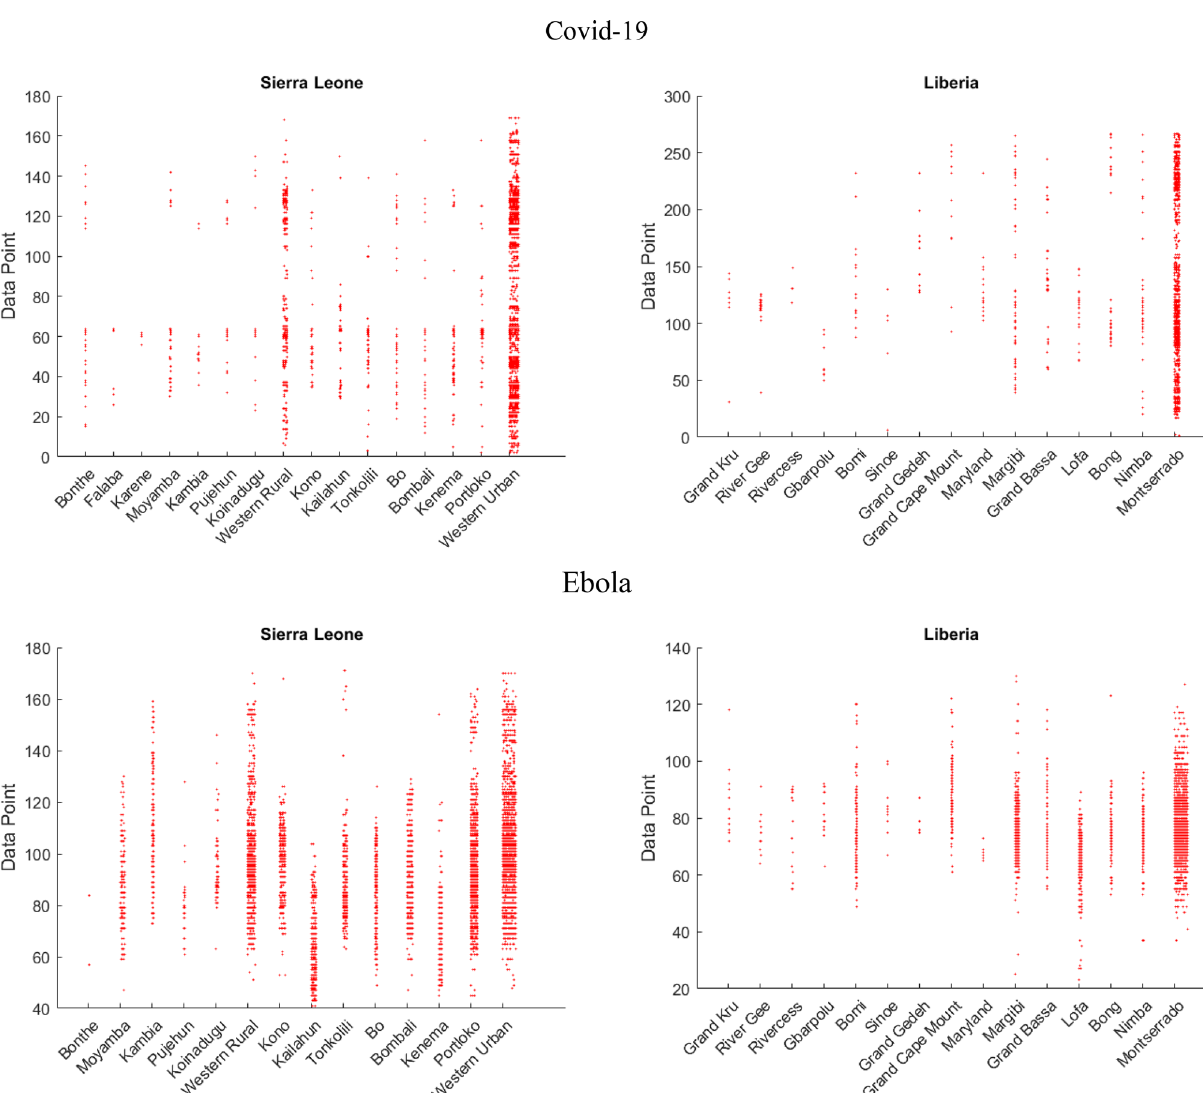
Figure 7. Shows the frequency of newly reported cases in Liberia and Sierra Leone across their